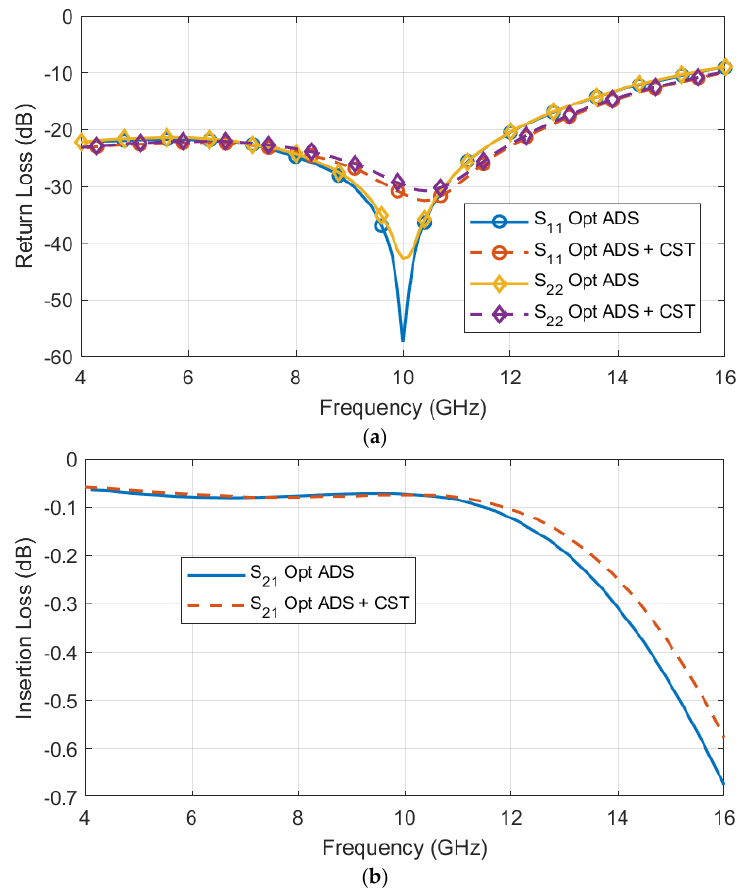
Figure 11. Stripline to coaxial connector transition: ( a ) S 11 and S 22 , ( b ) S 21 .